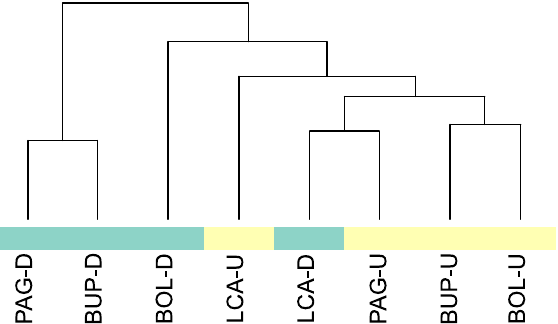
Figure 2. Distance matrix of metagenomic data analyzed at the OTU level. Analysis of the isolates at this level shows significant (p-value = 0.05) clustering according to whether the surfaces are: damaged—blue; or undamaged—yellow, with the exception of Lincoln Cathedral where the presence of Fusobacteria and Aquificae results in the clustering of the damaged sample with undamaged and the higher level of Acidobacteria grouping the undamaged site in with damaged sites.